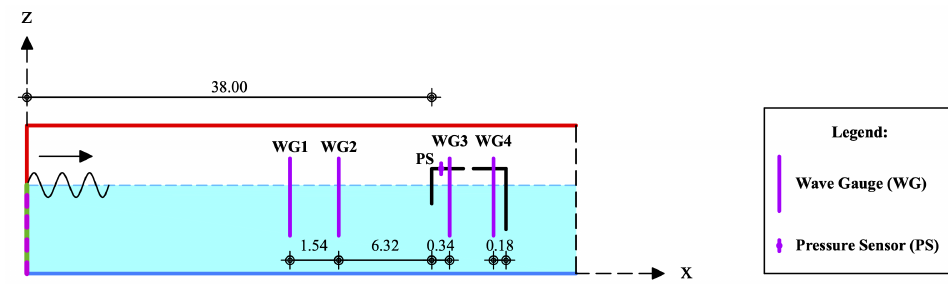
Figure 9. Location of wave gauges and pressure sensors.